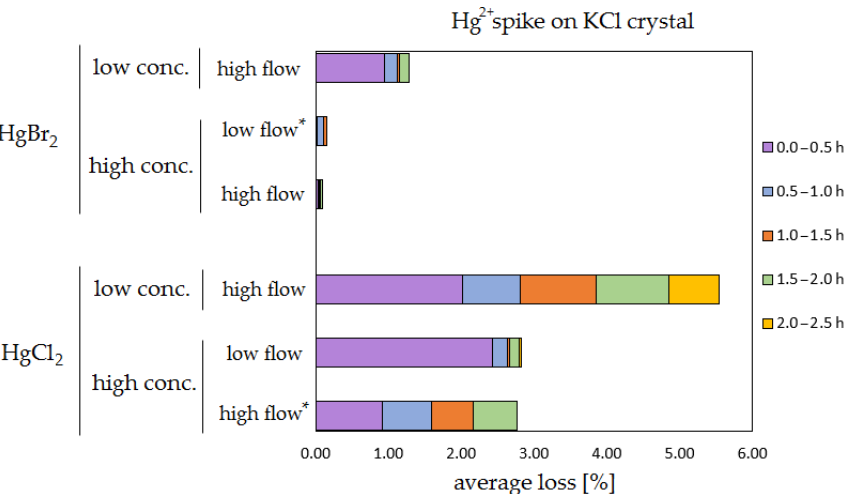
Figure 6. Results of the stability test for the 197 Hg 2 + (radiotracer) spike on KCl crystal. Low concentrations were loaded with less than 1ng Hg per time period, and high concentrations were loaded with more than 50ng of Hg per time period. Low airflow experiments were performed with 100mLmin − 1 airflow, while high airflow experiments were performed with 400mLmin − 1 flow. Asterisks mark the results that only have the first four time periods.